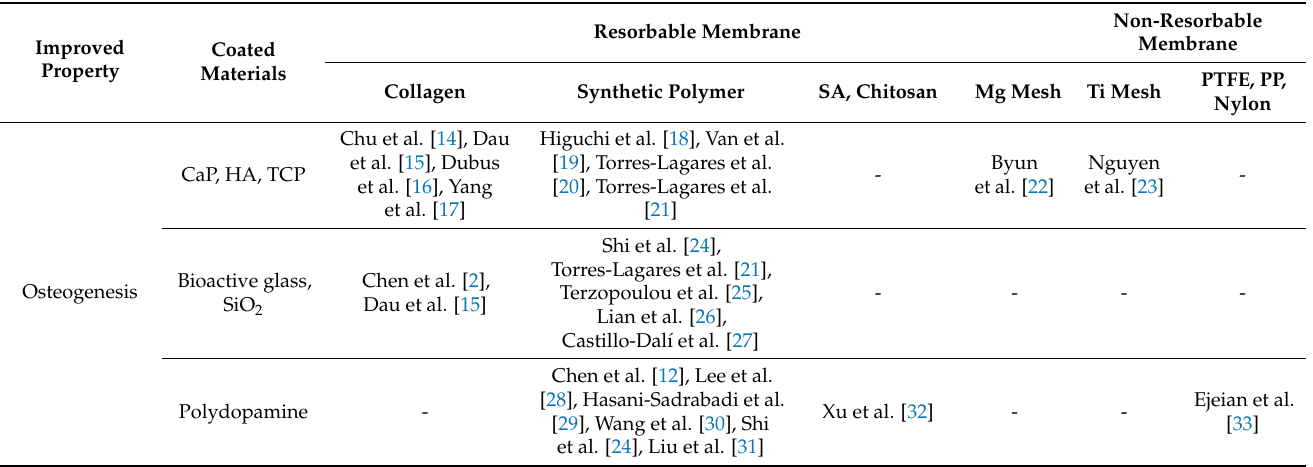
Table 1. Summary of included studies on coated barrier